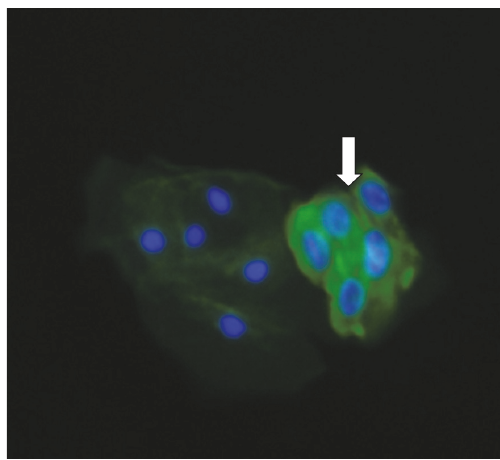
Figure 1: The white arrow indicates the presence of clustered podocytes, as bright green fluorescent cells. A tubular cell is observed to the left. Fluorescent microscopy, ×